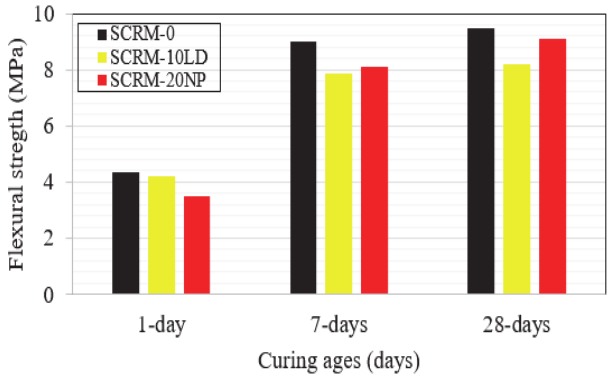
Figure 7: Variation of flexural strength with age for SCRMs.